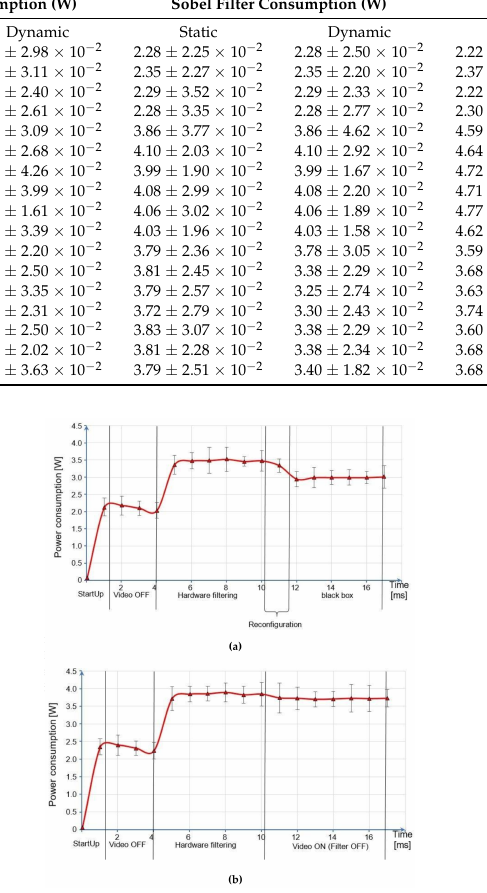
Figure 7. Power consumption versus time plot concerning the two different systems for the posterize-filtering DSP: ( a ) the dynamic partially reconfigurable architecture; ( b ) the static architecture. For each reported value, obtained as average of the 15 performed measurements, the error bar denoting the standard deviation is also